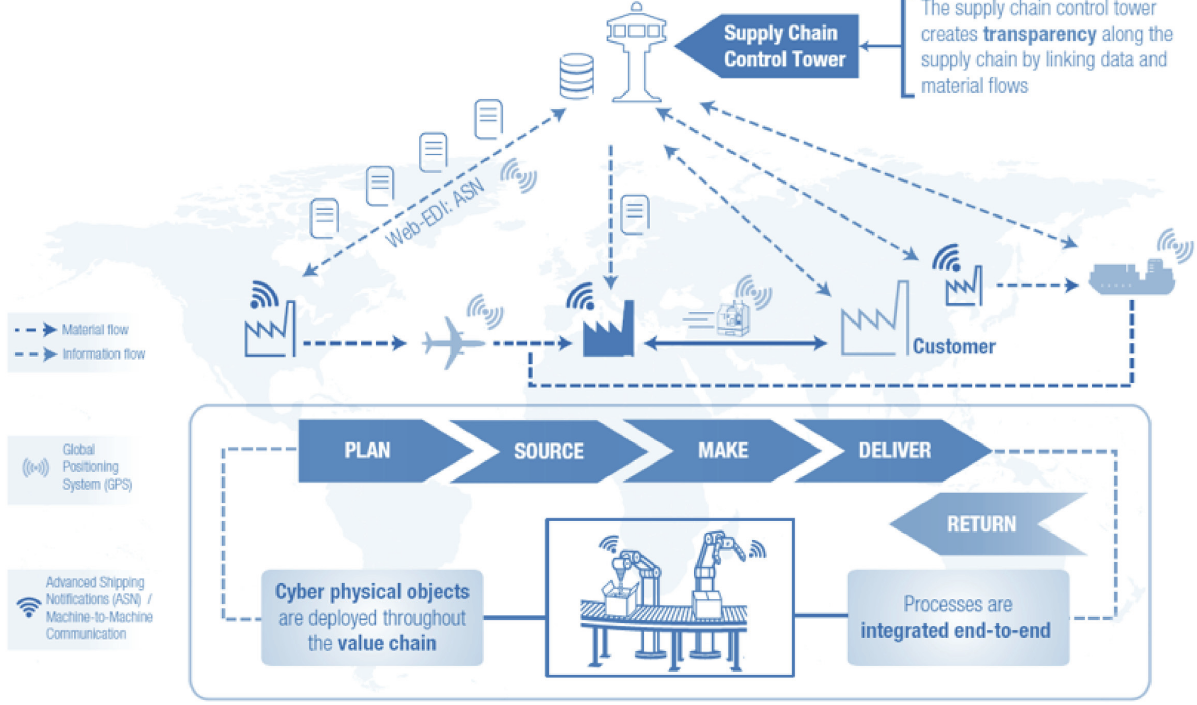
Figure 3: The structure of horizontal integration. Components of the partnership can be found all over the world. An organized supply chain is formed for tracking the life cycle of the product. Planning, sourcing, manufacturing, and delivery processes operate simultaneously. Cyber-physical systems and their connectivity via GPS or Internet enable full communication in order to set the optimal parameters [15].